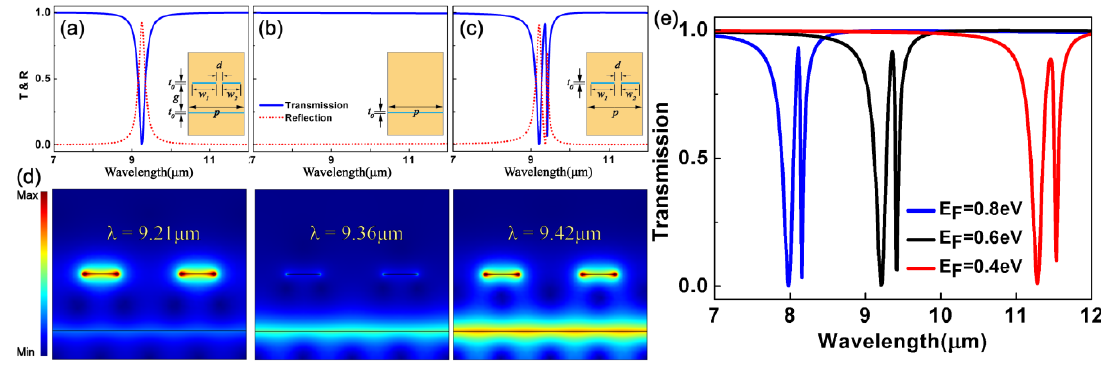
Figure 2. ( a – c ) Transmission and reflection spectra for the basic unit at normal incidence. The inset graphs are the diagrammatic sketch of graphene nanostructures under research. There are two graphene nanoribbons acting as the bright element. The graphene sheet layers are acting as the dark element. The basic unit of the graphene plasmonic structure aims to achieve plasmon-induced transparency (PIT). It is constructed by combining the bright element with the dark element. Blue areas represent graphene; ( d ) The |E| distributions corresponding to three different wavelengths; ( e ) Transmission spectra of the system for chemical potential E F = 0.4, 0.6, and 0.8